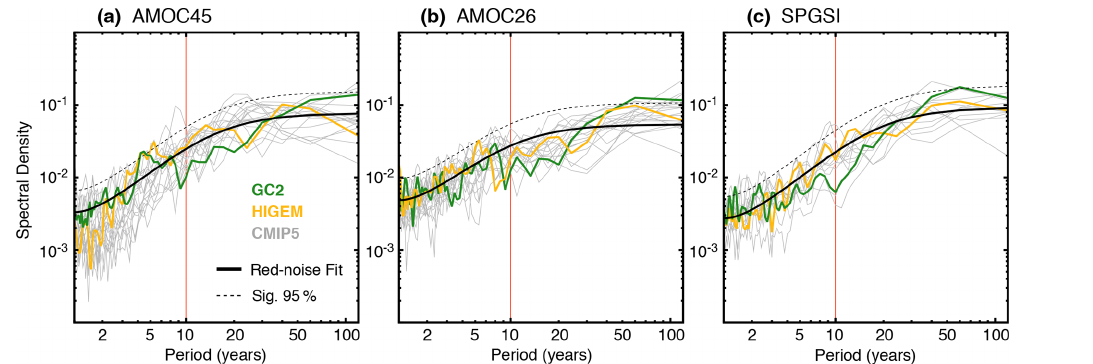
Figure 3. (a–c) Fourier spectra in the picontrol ensemble for the indices AMOC45, AMOC26, and SPGSI. Red noise spectra corresponding to a first-order autoregressive process fit to GC2 indices are provided as a reference.